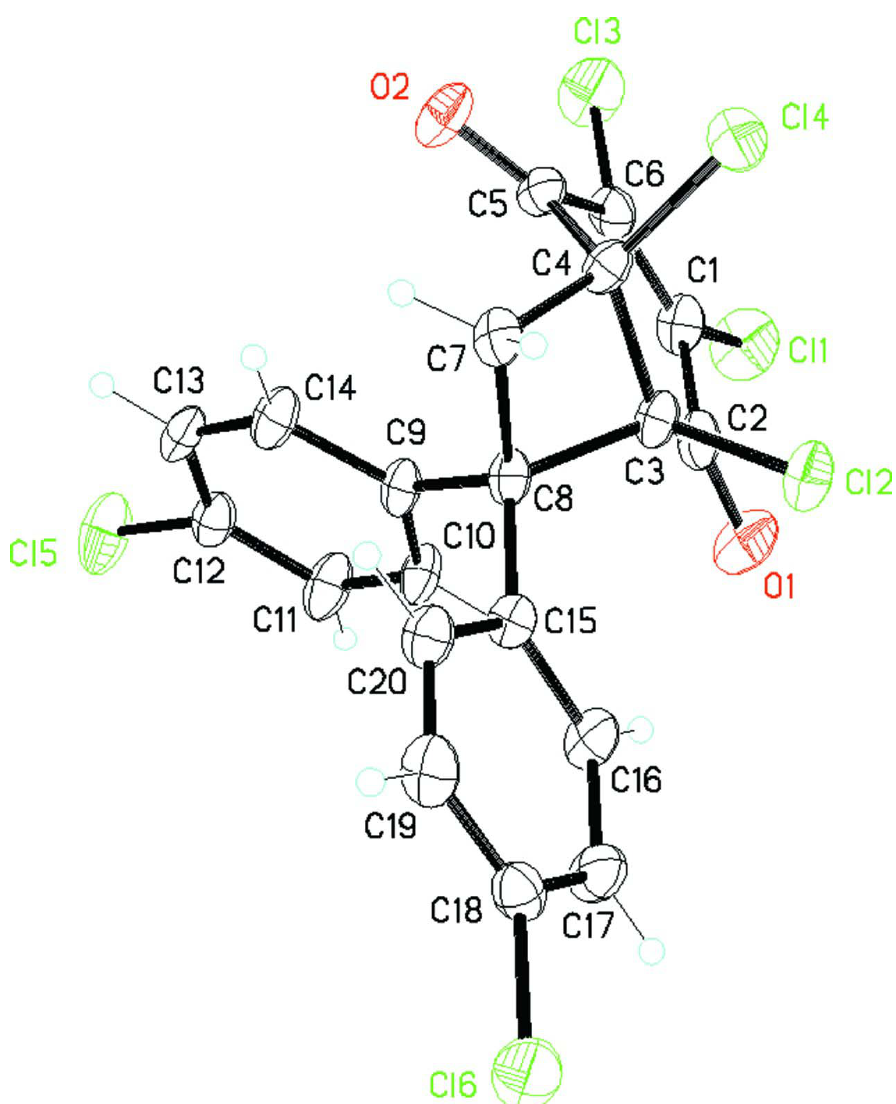
The molecular structure of the title compound with 30% displacement